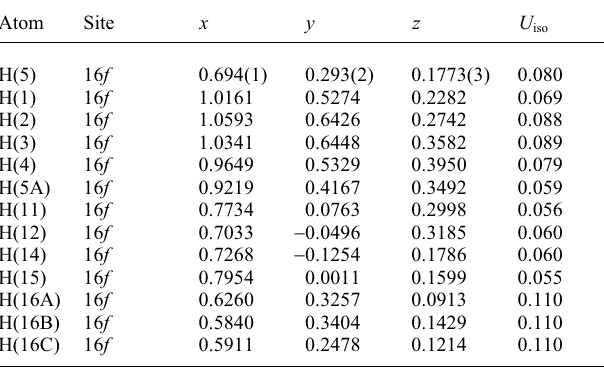
Table 2. Atomic coordinates and displacement parameters (in Å 2 )